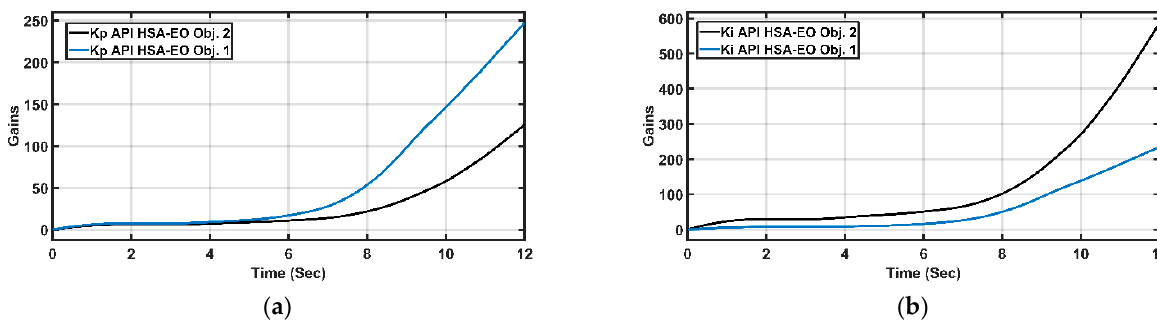
Figure 30. ( a ) (cid:1837) (cid:3043) adaptive PI gain of faulty second case. ( b ) (cid:1837) (cid:3036) adaptive PI gain of faulty second case. Figure 30. ( a ) K p adaptive PI gain of faulty second case. ( b ) K i adaptive PI gain of faulty second case. Table 13. Numerical comparison between the controllers at faulty second case.